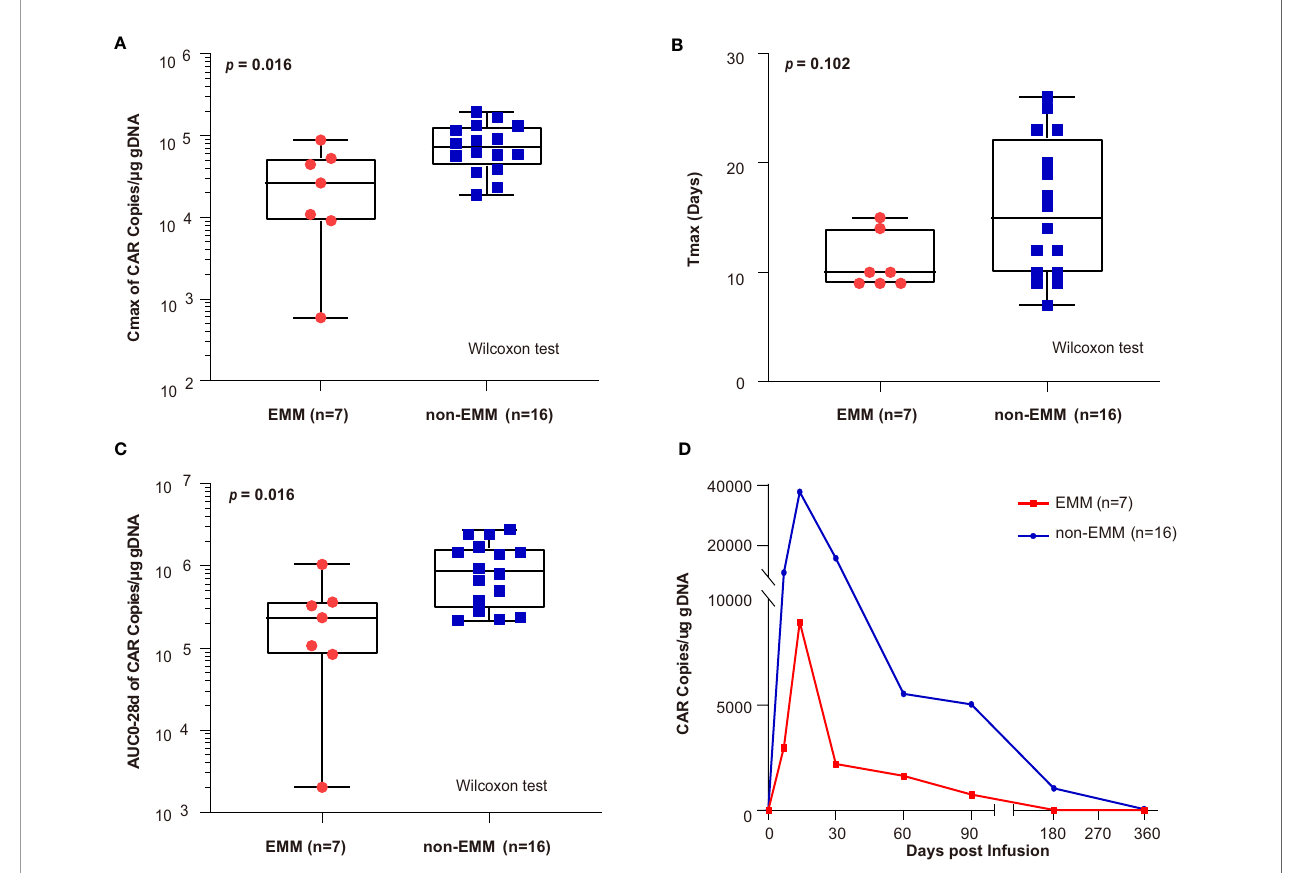
FIGURE 4 | Comparison of CAR transgene kinetics between EMM patients and non-EMM patients receiving novel fully human anti-BCMA CAR-T infusion conducted in our center (A – C) the comparison of C max , T max , and area under the curve of the transgene level from infusion to 28 days (AUC 0 – 28d ) between EMM and non-EMM patients that received novel fully human anti-BCMA CAR-T therapy. The p value is based on a twosided Wilcoxon ranksum test and p values less than 0.05 (two-tailed) was considered statistically signi fi cant. (D) The Car copies from infusion to the last follow-up were compared between EMM and non-EMM patients. Data presented as a geometric mean. AUC 028d , area under the curve during the fi rst 28 days after the infusion; Cmax, peak value of CAR copies; Tmax, the time elapsed till peak value